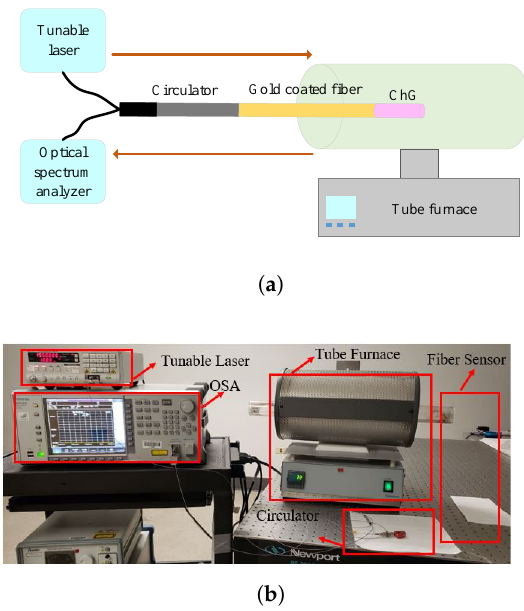
Figure 4. ( a ) Schematic of setup for testing the temperature performance of the fabricated sensors and ( b ) a picture of the actual device characterization